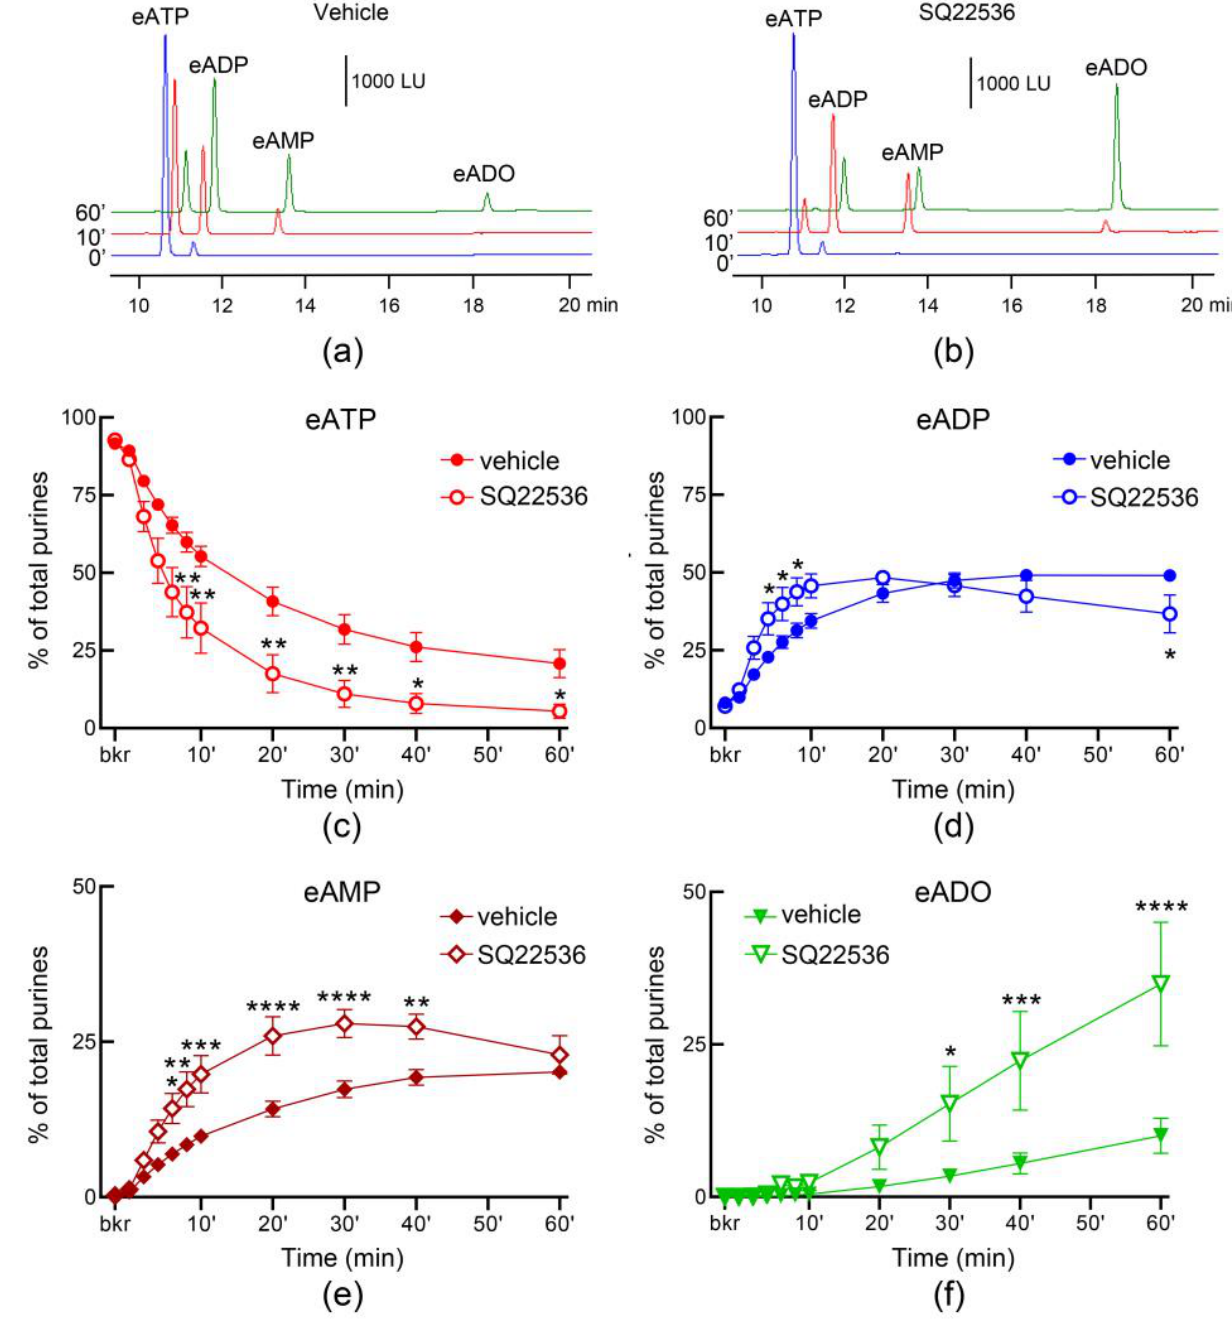
Figure 11. Effect of SQ22536 on the hydrolysis of eATP by soluble nucleotidases released in the lamina propria of distended denuded bladder preparations . Original chromatograms of eATP in beaker (blue, 0′), at 10 min (red), and at 60 min (green) after addition of eATP to concentrated ELS collected at the end of bladder filling in the presence of vehicle (DMSO 0.2%) ( a ) or SQ22536 (100 µM) ( b ). Summarized data of time courses of eATP decrease ( c ), eADP increase ( d ), eAMP increase ( e ), and eADO increase ( f ) after addition of eATP to concentrated ELS collected at the end of bladder filling. Note that the degradation of eATP was enhanced in the presence of SQ22536 ( n = 3) in com- parison with DMSO 0.2% control ( n = 4). * p < 0.05, ** p < 0.01, *** p < 0.001, **** p < 0.0001. 2 way ANOVA with Sidak’s multiple comparisons tests.